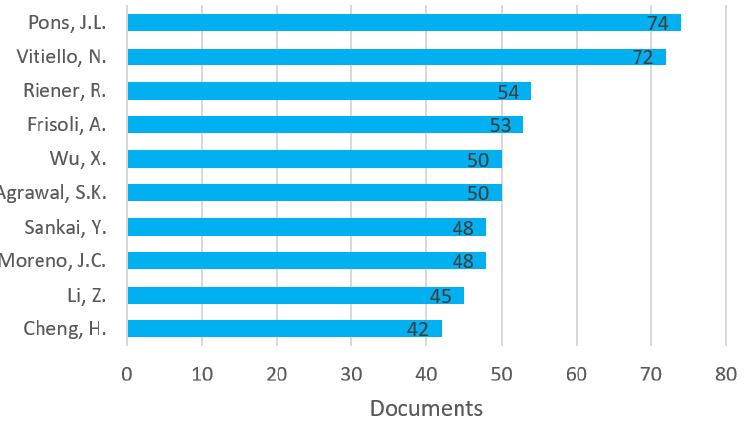
Figure 14. Graph of the top 10 authors by number of publications referring to exoskeletons be- tween 2010 and 2020.